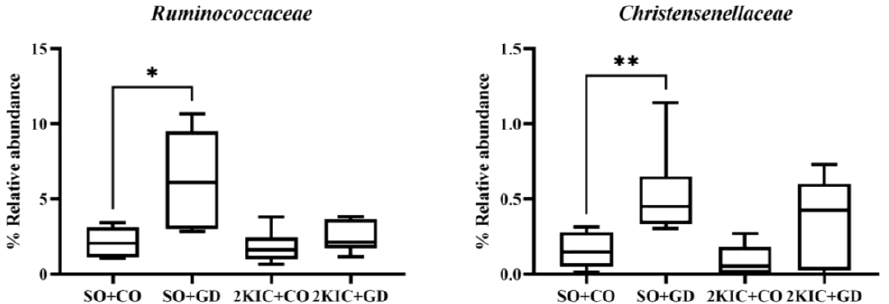
Figure 7. Composition alterations in gut microbiota at the family level. SO, sham operation; CO, corn oil; 2K, 2-kidneys-1 clip (2K1C); GD, Garcinia dulcis flower extract. * p < 0.05 and ** p < 0.01.